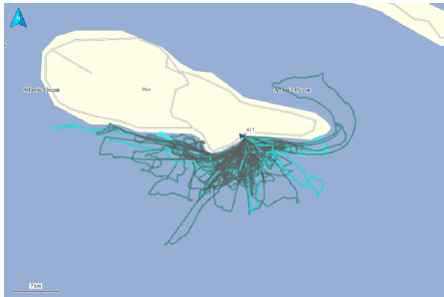
Figure 2. Map of the Azores study area with indication of the survey area investigated.